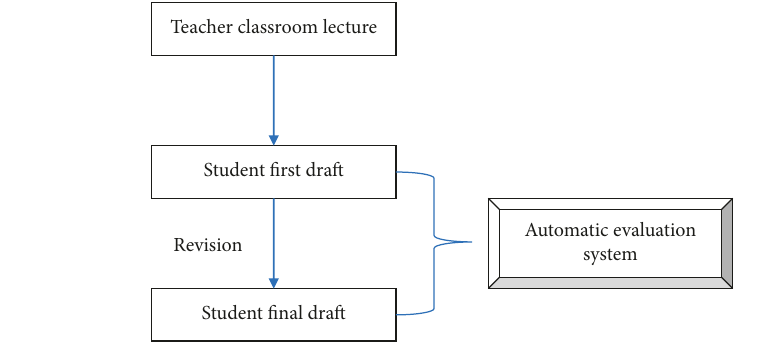
Figure 4: Process of teaching English